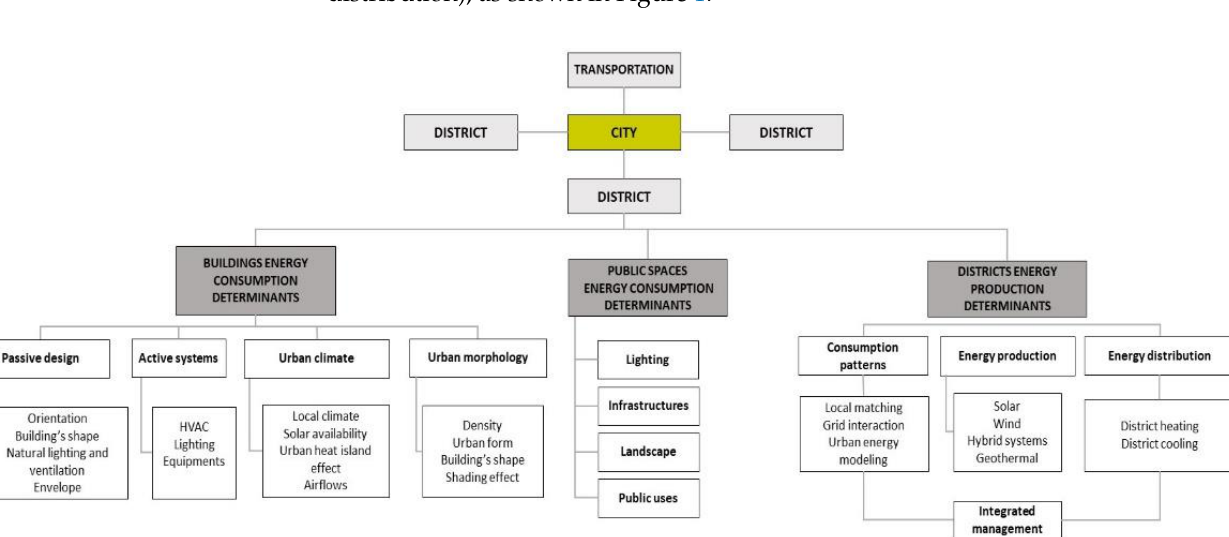
were equipped with BIPV systems on the roof. Overall, the two houses resulted in 30% less energy consumption. On an annual basis, 44% of the consumption can be generated